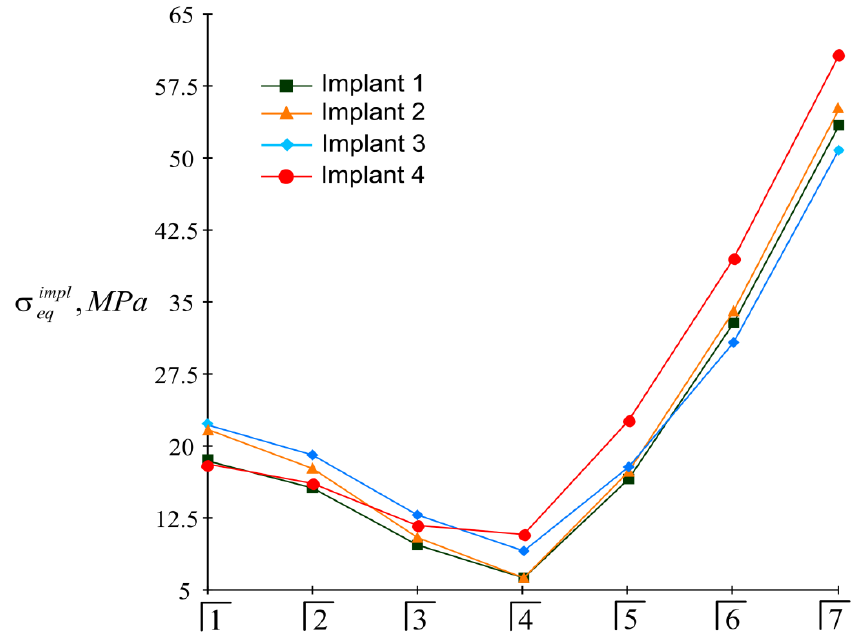
Figure 9. Comparative analysis of maximum equivalent stresses in implants at different mastication load locations (the first variant of implant placement).